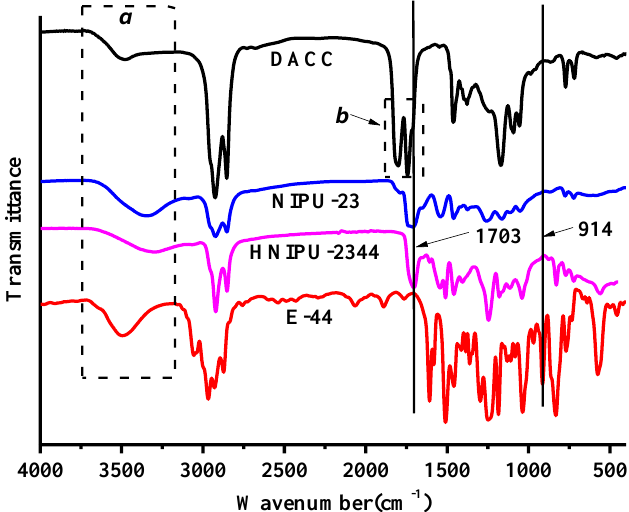
Figure 1. Fourier transform infrared spectroscopy (FTIR) spectra of synthesized HNIPU-2344-1 with their modification.